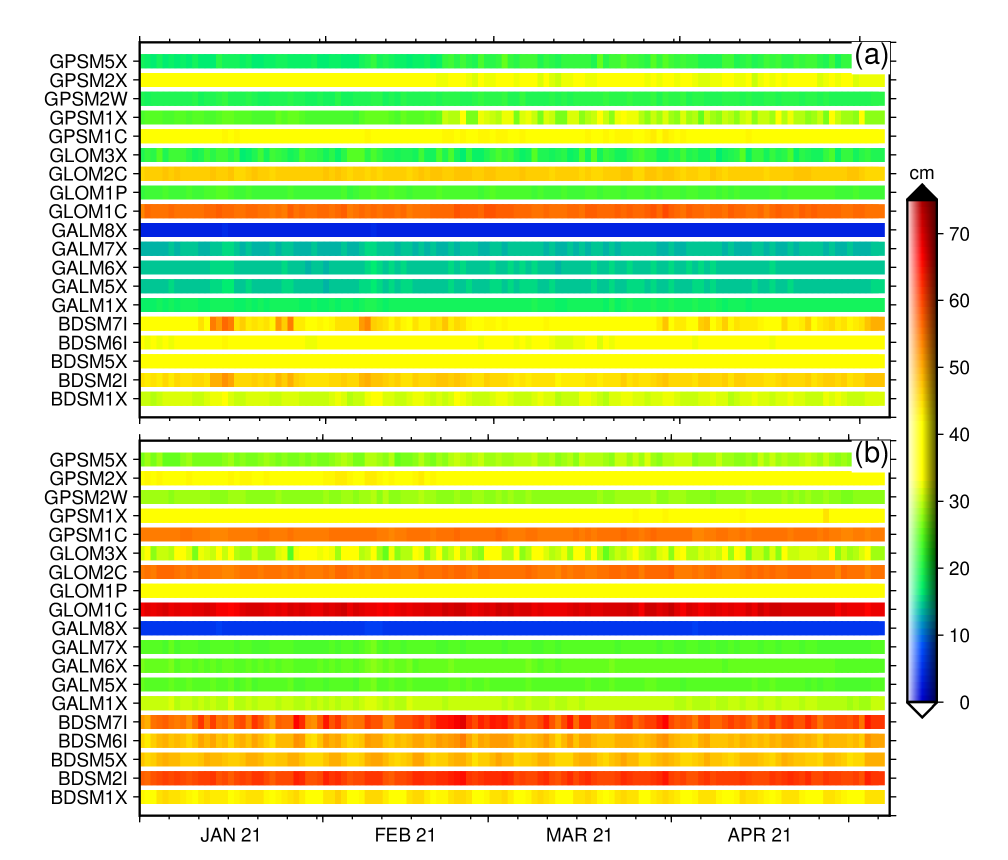
Figure 5. Pseudorange (Code) multipath estimated for all possible linear combinations as recorded at stations KBG1 ( a ) and KBG2 ( b ) during January–May 2021.